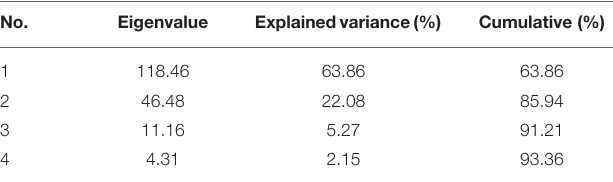
TABLE 1 | Explained variance of SATmax (detrended) of southern Africa south of 23 ◦ S.